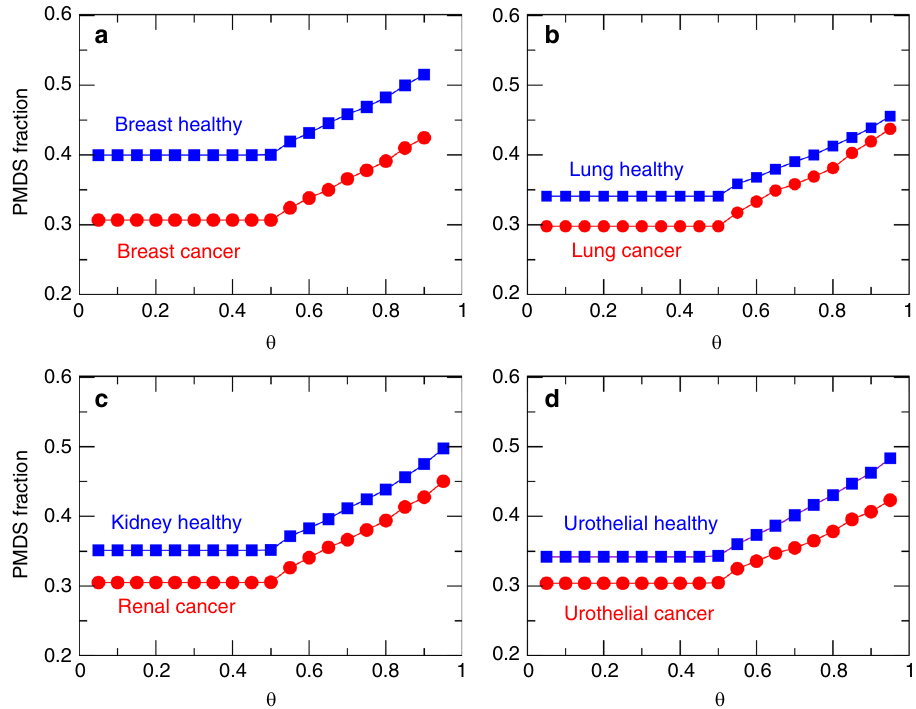
Fig. 5 Fraction of PMDS in healthy and cancer tissues. a – d The PMDS fraction in four healthy (blue) and cancer (red) tissues is displayed for different values of the threshold